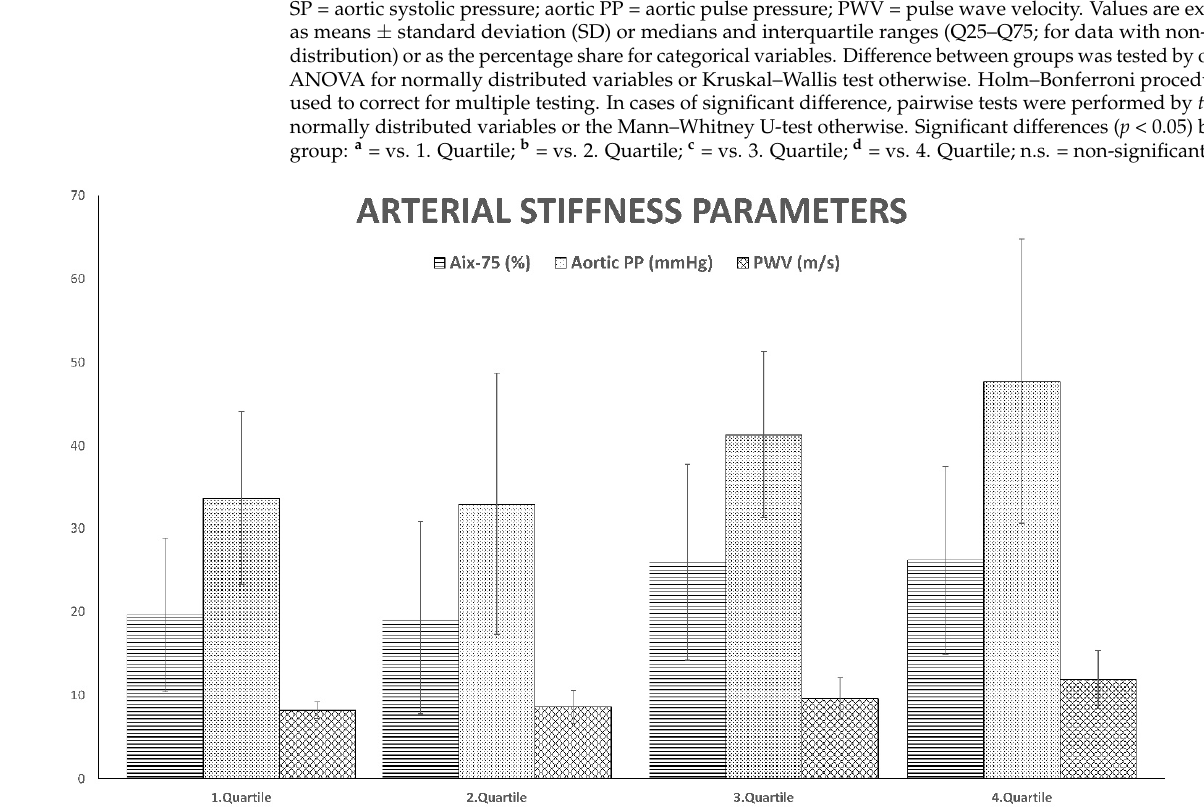
Figure 1. Selected parameters of arterial stiffness in individual quartiles according to age. AIx-75 = augmentation index normalized for a heart rate of 75 bpm; aortic PP = aortic pulse pressure; PWV = pulse wave velocity.